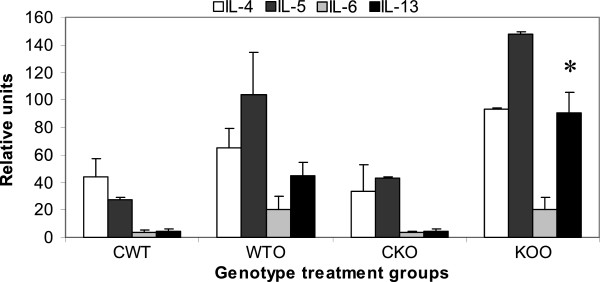
Alteration of TH cytokine gene expression in lung. Real time PCR analysis was used to quantitate expression of mRNA for the particular genes as calculated by relative index of Ct values normalized to GAPDH by real time PCR. PCR was carried out using the comparative Ct method (Applied Biosystems software) with SYBR Green PCRcore reagents (Applied Biosystems) and anlysed using Applied Biosystems 7900HT Real-Time PCR System software SDS 2.2.1. All primers used were specific to mouse. Data expressed here are mean ± SEM. n = 5/group. While all other Th2 cytokine levels were comparable to WT+OVA, IL-13 concentration was increased 2.7-fold over post-OVA WT values. Abbreviations used are: CWT = saline treated control wildtype, WTO = WT+OVA, CKO = gp91phox−/−+alum, KOO = gp91phox−/−+OVA. MMP-12.